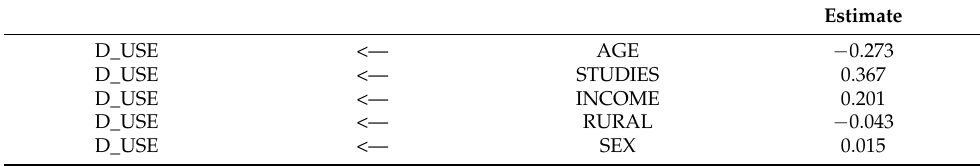
Table A5. Standardized Regression Weights: (Group number 1-Default